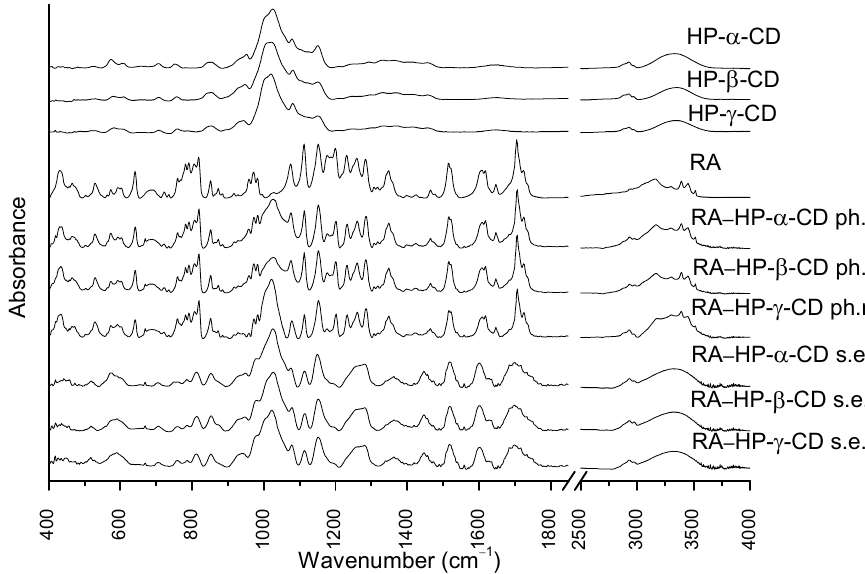
Figure 4. The FT-IR spectra of HP- α -CD, HP- β -CD, HP- γ -CD, RA, physical mixtures: RA–HP- α -CD ph.m., RA–HP- β -CD ph.m., RA–HP- γ -CD ph.m., and systems obtained by the solvent evaporation method (s.e.): RA–HP- α -CD s.e., RA–HP- β -CD s.e., RA–HP- γ -CD s.e. The RA bands at 3454 cm −1 , 3396 cm −1 , and 3168 cm −1 corresponding to O-H and C-H